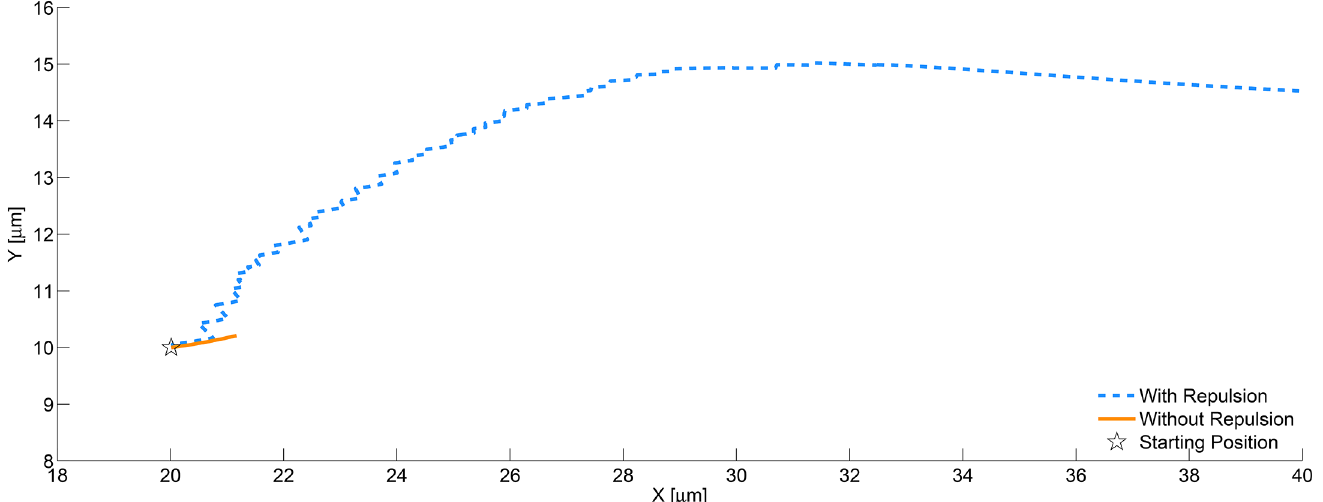
Fig 4. Trajectories of melanoma cell from CFD simulation, with and without repulsion. The results from the simulation shown in Fig 3 is post-processed to extract the centroid location of the melanoma cell throughout the simulation. That data was used to create a trajectory for each of the two cases. The case without repulsion (solid line) has a short path due to the collision with the PMN cell. The case with repulsion activated (dashed line) shows the body moving over and pass the PMN body. In this particular simulation, the motion of the centroid is planar (z =